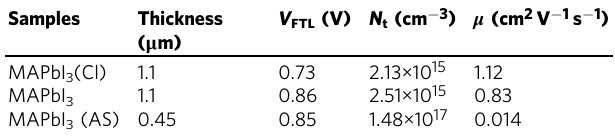
Table 1 The SCLC results for FTO/perovskite/Au devices based on 1.1- μ m-thick MAPbI 3 (Cl) and MAPbI 3 fi